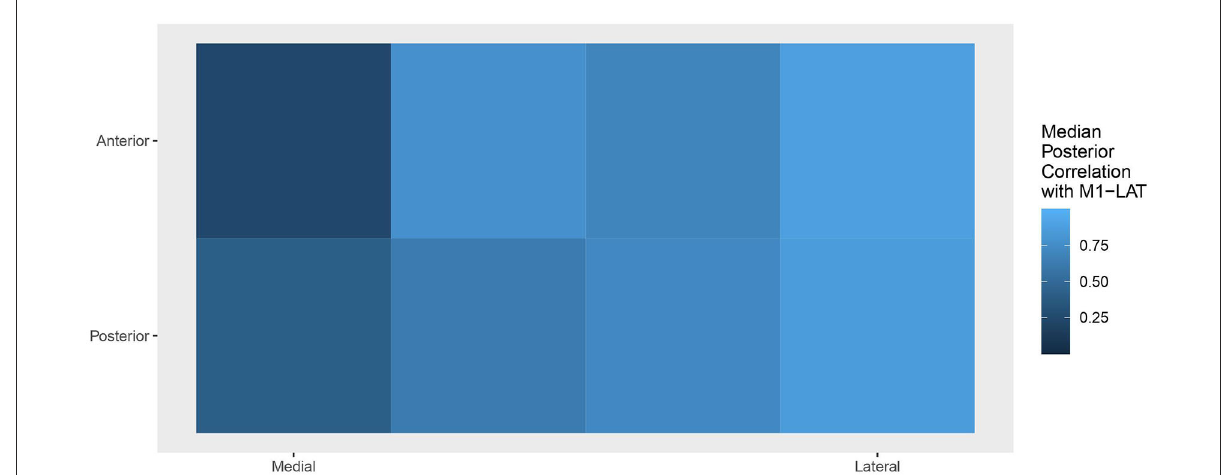
FIGURE7 Topology of the correlations relating each location to the latent M1-LAT sub-trait, with the posterior at each location collapsed to a median. Squares on the left represent the M1-LAT values calculated between the most medial fNIRS measurement locations; whereas squares on the right represent the M1-LAT values calculated between the most lateral fNIRS measurement